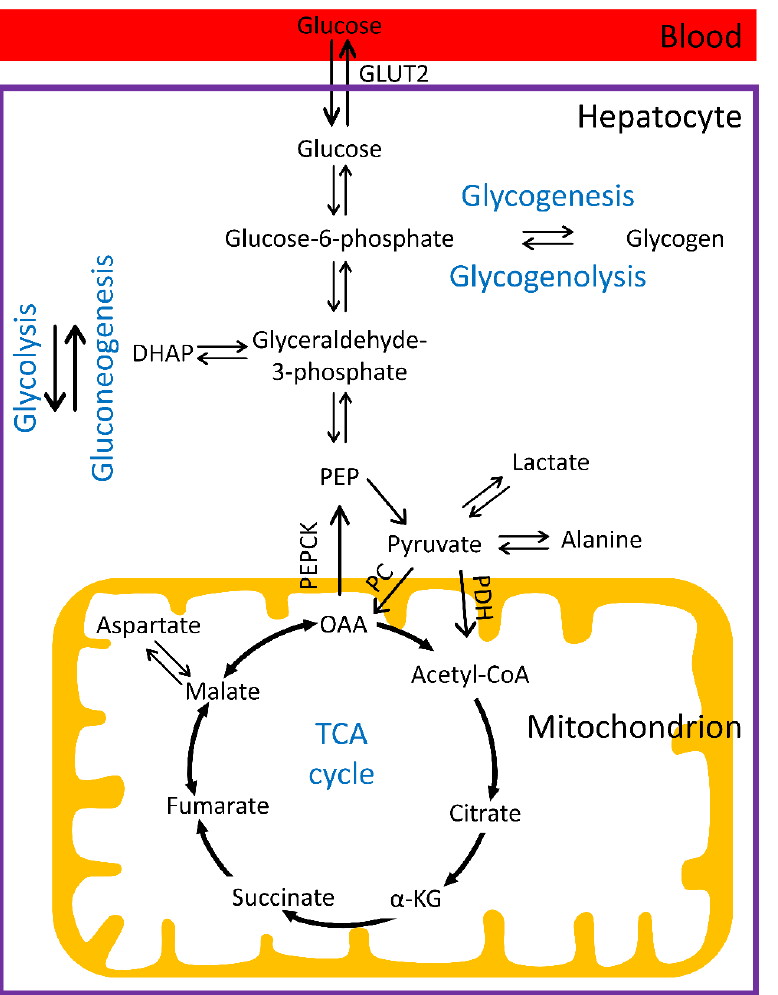
Figure 1. Schematic of hepatic glucose metabolism. α -KG, alpha-ketoglutarate; DHAP, dihydroxy acetone; GLUT2, glucose transporter 2; OAA, oxaloacetate; PC, pyruvate carboxylase; PDH pyruvate dehydrogenase; PEP, phosphoenolpyruvate; PEPCK, phosphoenolpyruvate carboxykinase; TCA, tricarboxylic